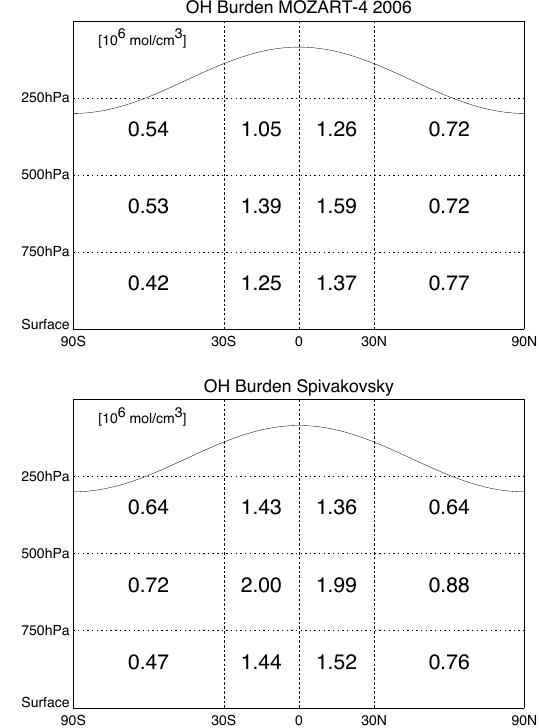
Fig. 4. OH burden from MOZART-4 compared to the climatology of Spivakovsky et al.